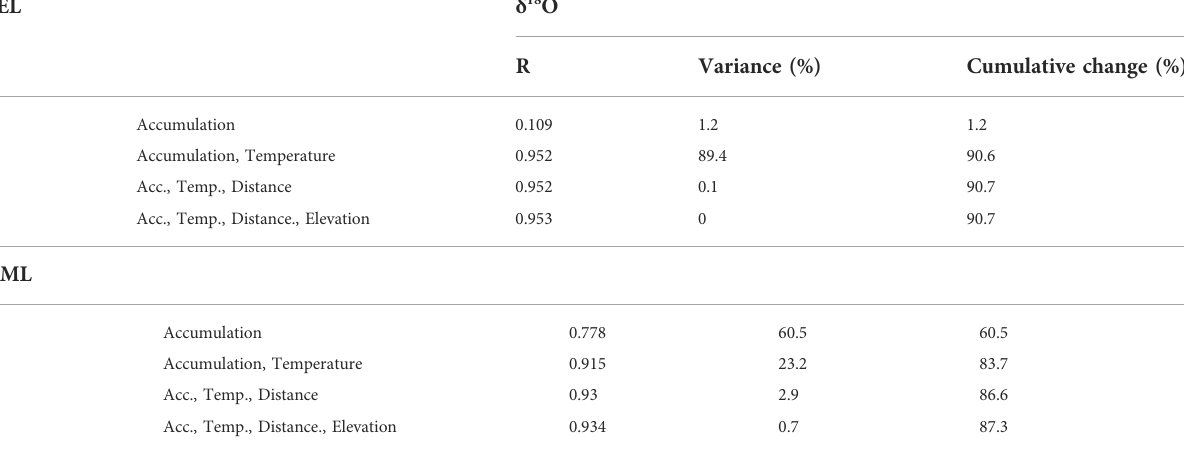
TABLE 4 Hierarchical multiple regression analysis explaining the percentage of stable isotope variability attributed to accumulation, temperature, and other physical parameters. Temperature effect is clear in PEL while precipitation effect is dominant in DML region. PEL δ 18